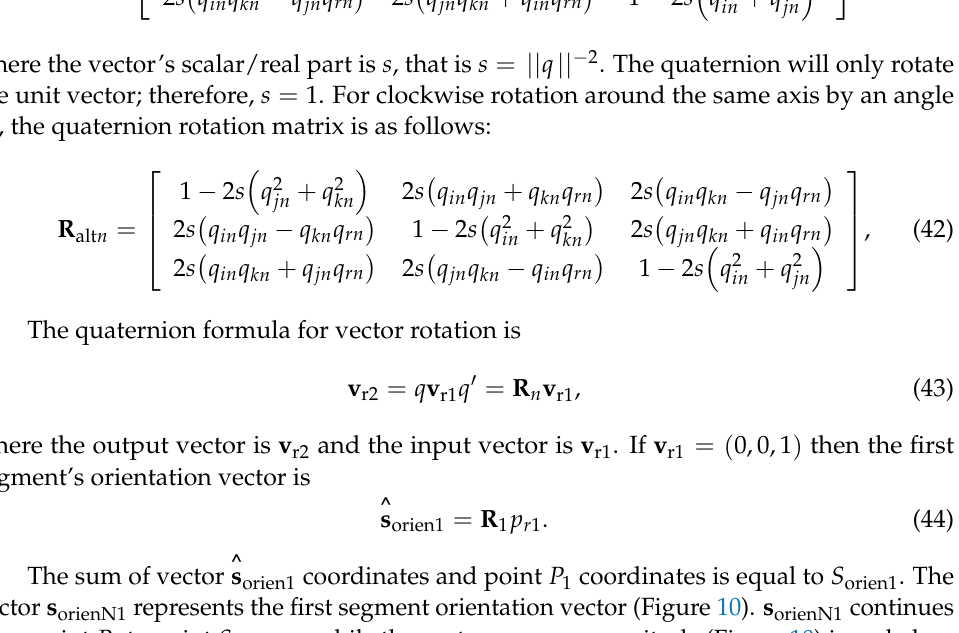
^ s orien1 coordinates and point P 1 coordinates is equal to S orien1 . The The sum of vector vector s orienN1 represents the first segment orientation vector (Figure 10). s orienN1 continues from point P 1 to point S orienN1 , while the vector s orienN1 magnitude (Figure 10) is scaled up for illustration